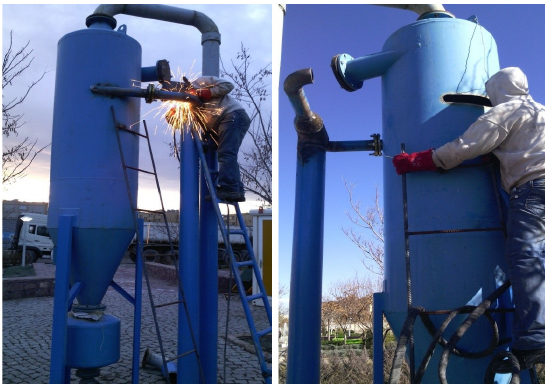
Fig. 4. Stages of cutting inlet gate to